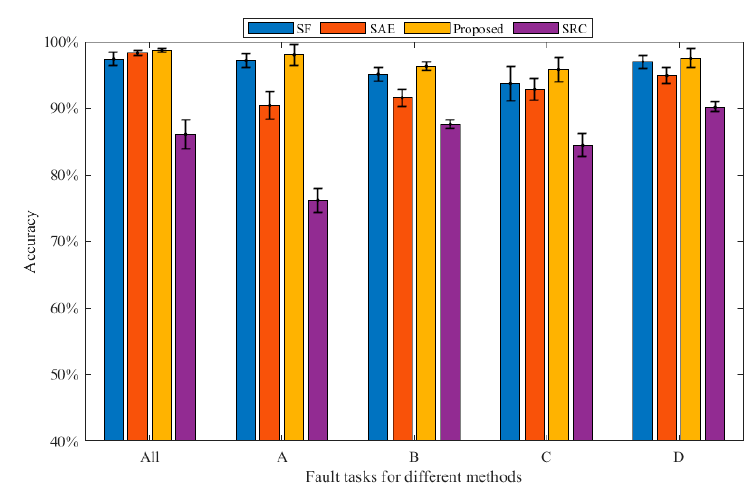
Figure 4. Bearing diagnosis results of the three methods under various working conditions. Table 2. The detailed diagnostic results (%) of the bearing data.